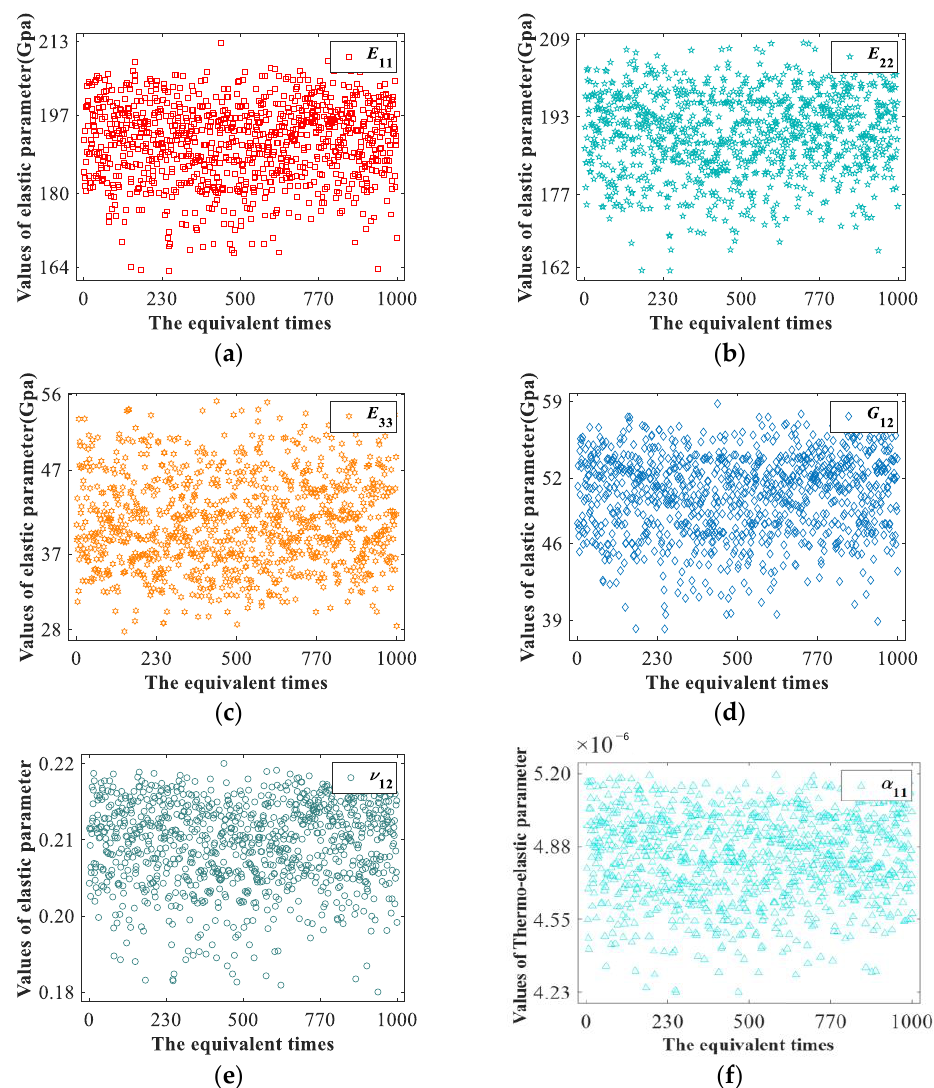
Figure 8. The scatter plots of equivalent results. ( a ) E 11 Equivalent result scatter diagram. ( b ) E 22 Equivalent result scatter diagram. ( c ) E 33 Equivalent result scatter diagram. ( d ) G 12 Equivalent result scatter diagram. ( e ) ν 12 Equivalent result scatter diagram. ( f ) α 11 Equivalent result scatter diagram.